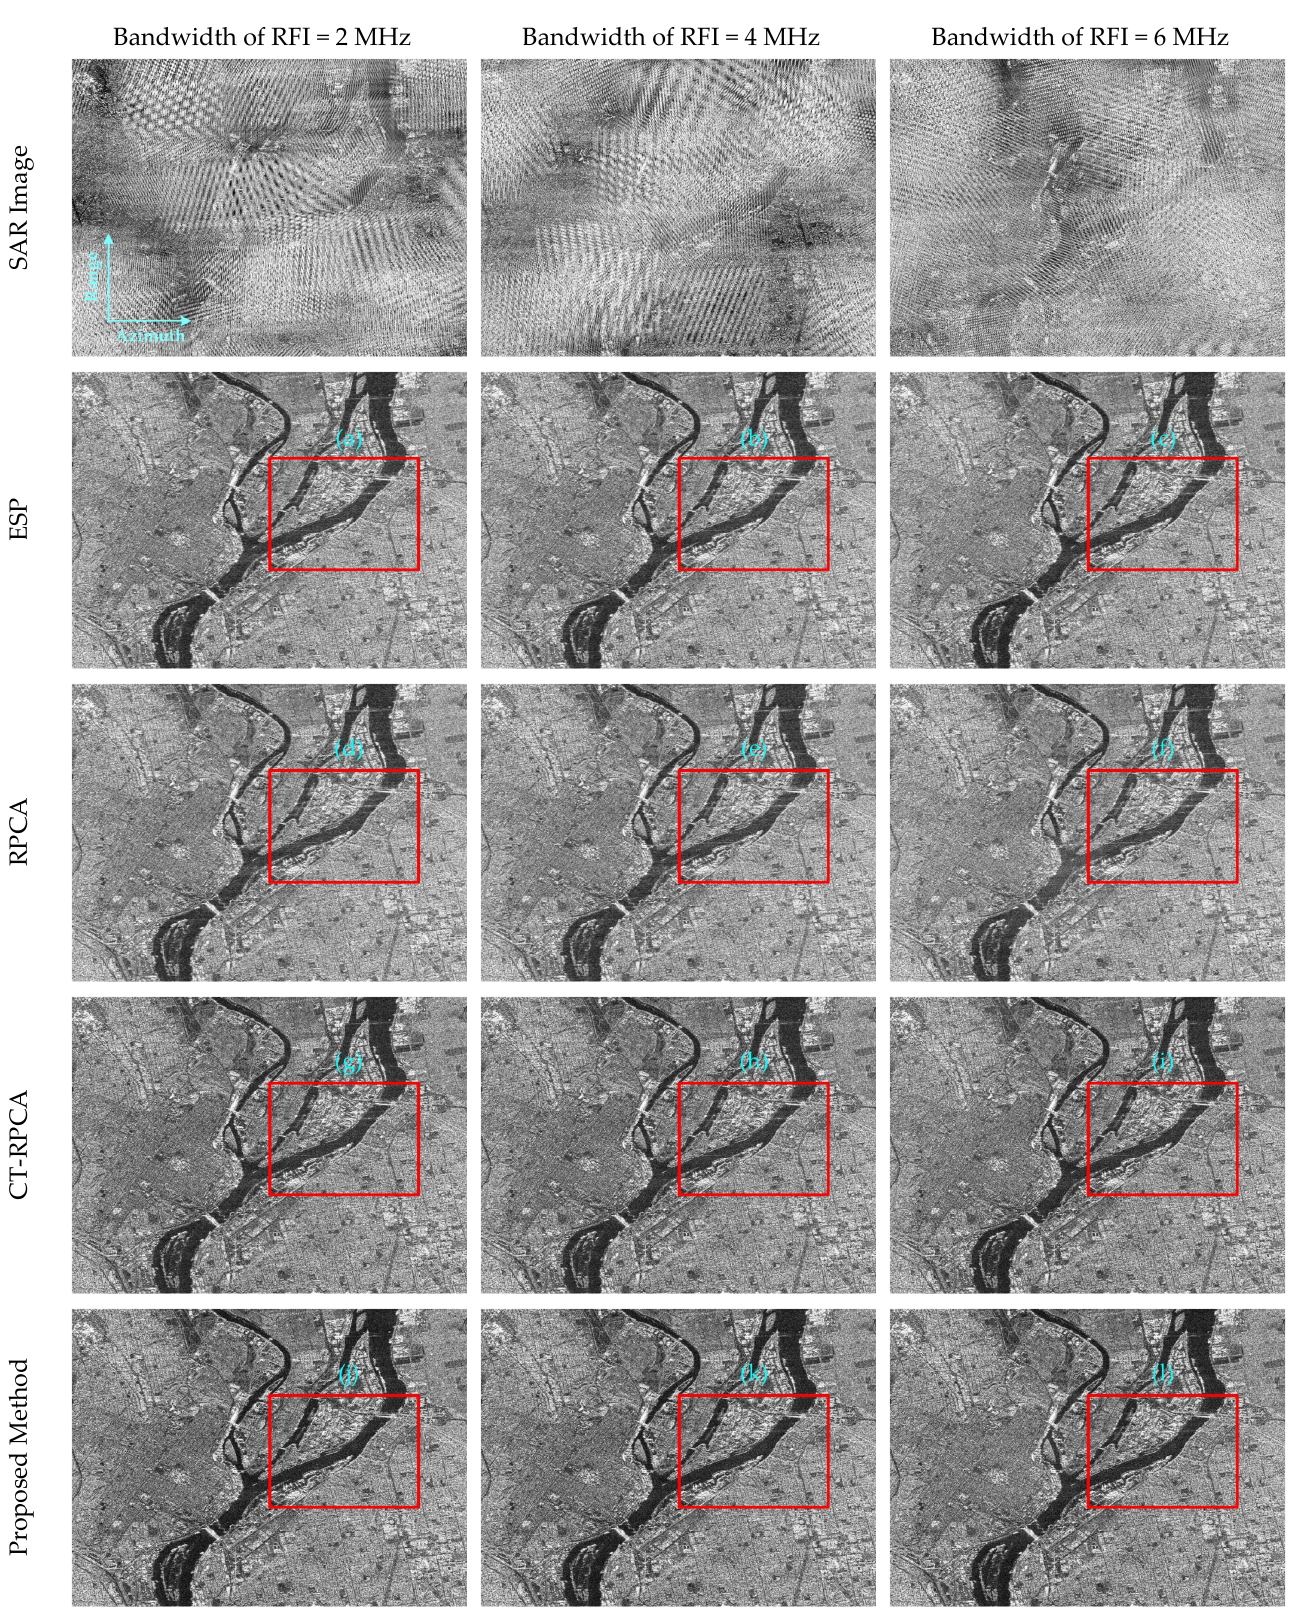
Figure 8. Mitigation performance for the ESP, RPCA, CT-RPCA, and proposed approach under different bandwidths of RFI. ( a – l ) ROIs for RFI mitigation results of different methods.